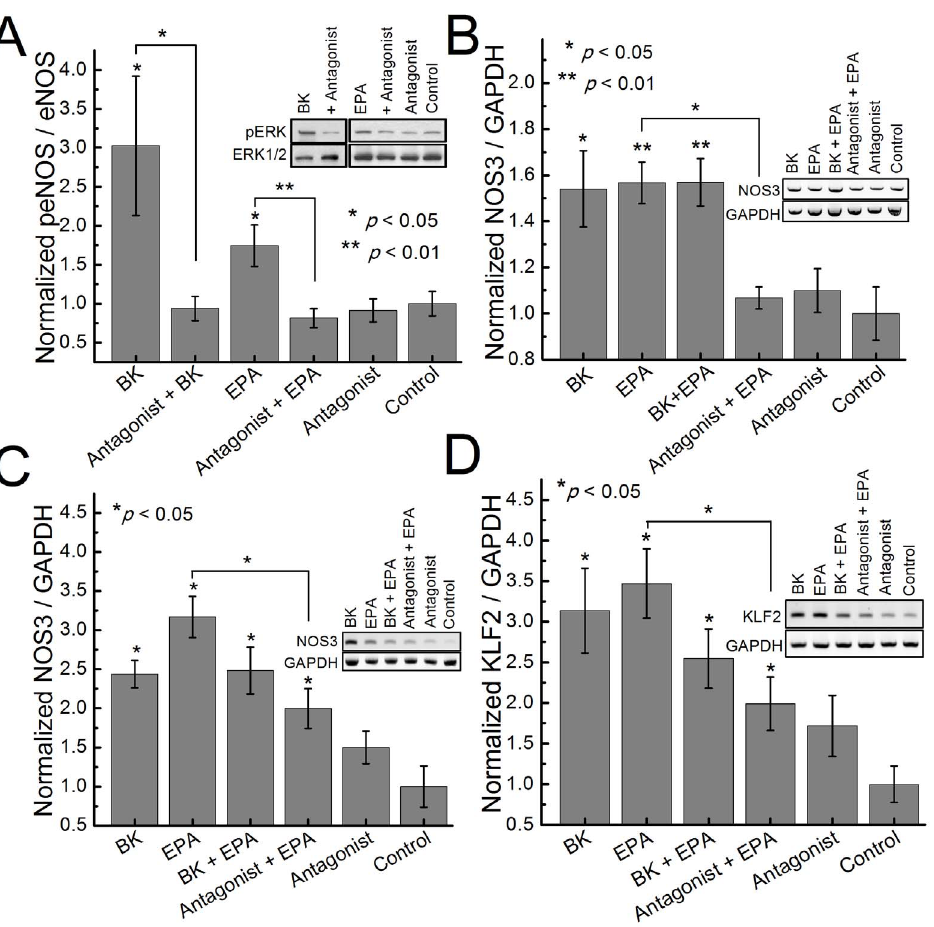
Figure 5. Fatty acids cause eNOS activation and alters NOS3 and KLF2 expression. (A) Effect of 1 m M of B 2 R antagonist HOE-140 on peNOS stimulated with: 10 nM bradykinin or 1 m M EPA on BAECs in DPBS for 5 minutes at 37 u C. Effect of 1 m M of B 2 R antagonist HOE-140 on NOS3 expression with 10 nM BK or 1 m M EPA (B) BAECs and (C) HCAECs DPBS for 1 hour at 37 u C. (D) Effect of 1 m M of B 2 R antagonist HOE-140 on KLF2 expression with 10 nM bradykinin or 1 m M EPA. Data represent the mean of at least four independent experiments.